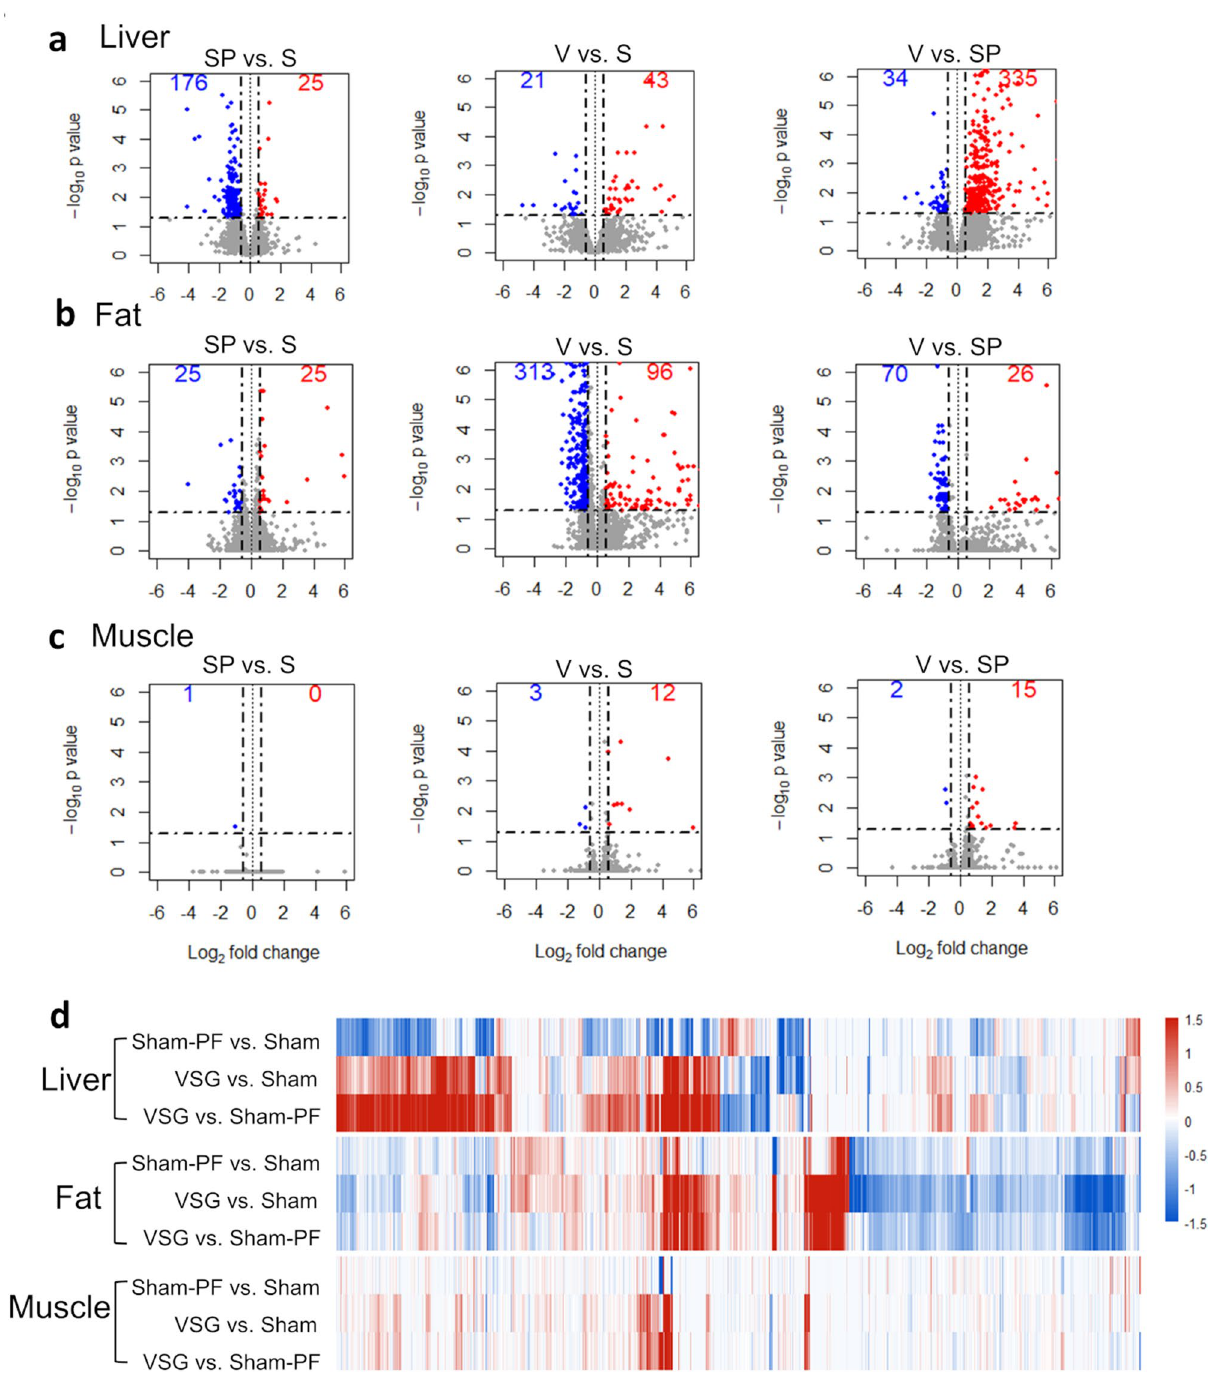
Figure 3. Global gene expression profiles of the liver, fat and muscle. The volcano plot of ( a ) the liver, ( b ) fat and ( c ) muscle. The DEG was defined as adjusted P value < 0.05 and fold change ≥ 1.5. ( d ) Heatmap showing log 2 fold change in the three comparison: sham-PF versus sham, VSG versus sham, and VSG versus sham-PF. Each column represent a gene and genes that showed adjusted P value < 0.05 in any of the three organs are included in the heatmap. The numbers of mice included in the RNA sequencing analysis were 4, 3, and 3 for the sham, sham-PF, and VSG group, respectively. S, Sham group; SP, sham-PF group, V, VSG